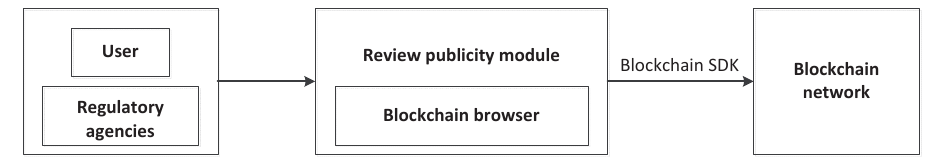
Fig. 7 Workflow of the review publicity